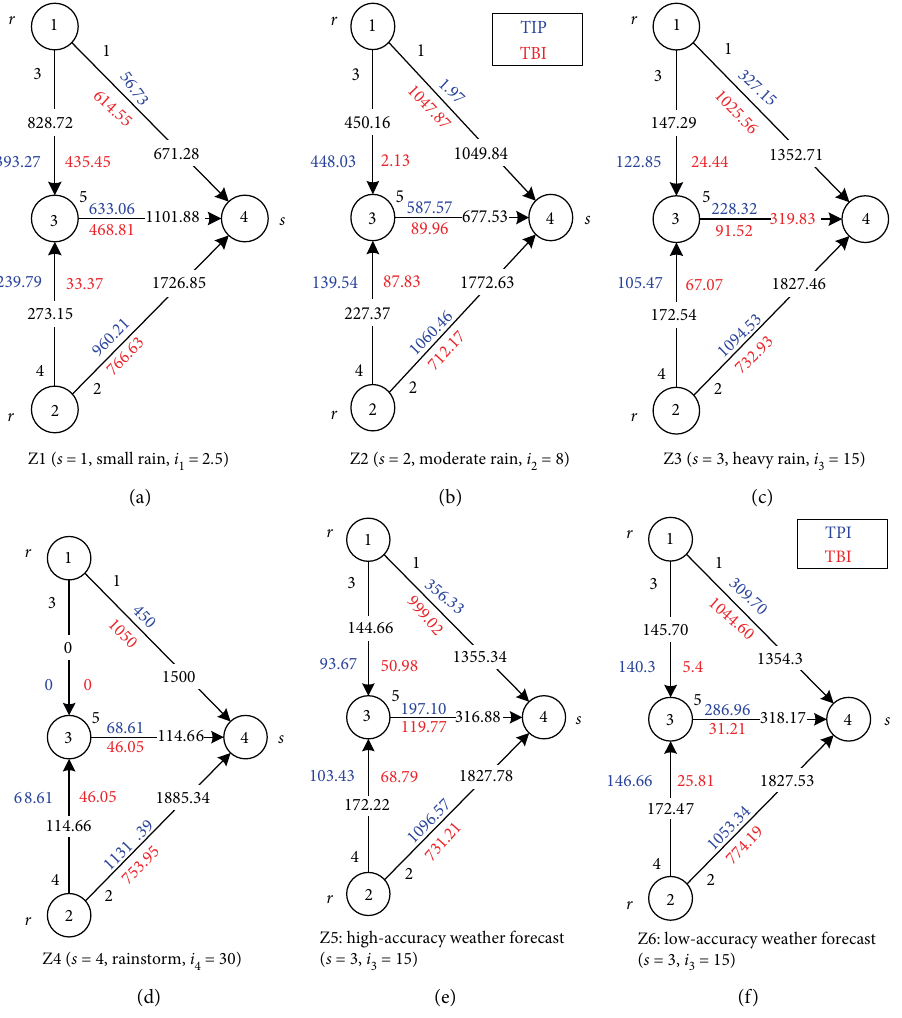
Figure 7: Equilibrium flow patterns in